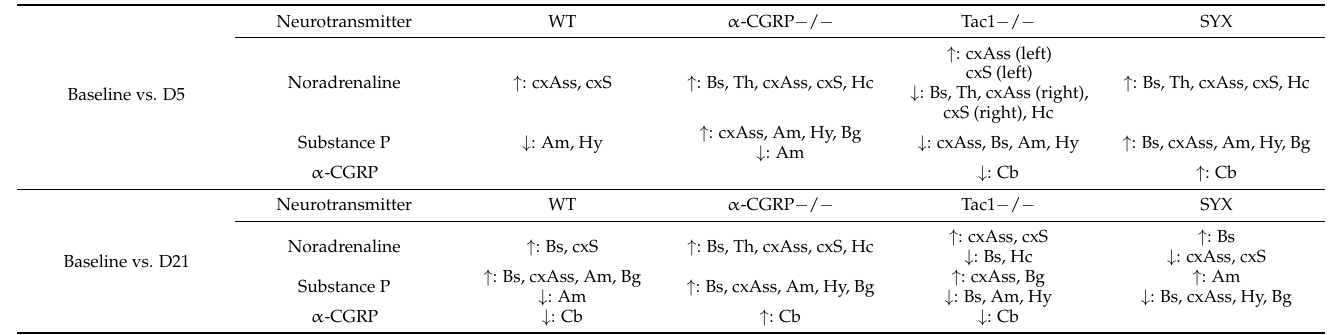
Table 3. Gene expression network correlation analysis data corresponding to Figure 7 (resting state). Data provide an overview of which neurotransmitters (of those modulated by our mouse models) are mainly expressed in the affected brain